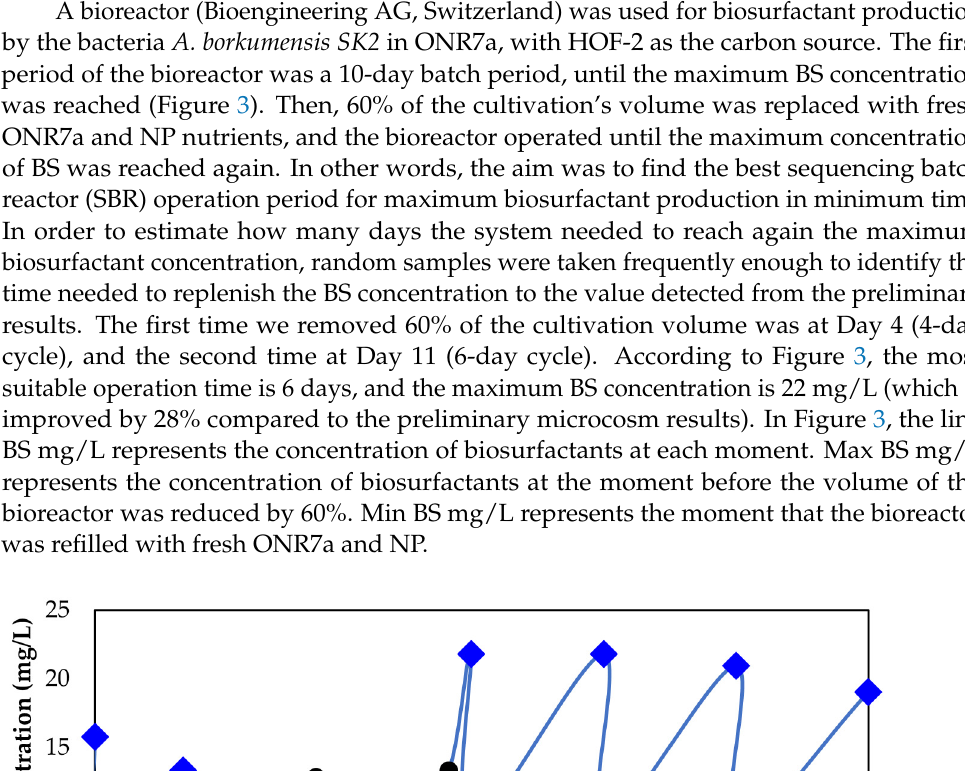
Figure 4. BFT efficiency test of BS-in-SOY agent with BS produced by Alcanivorax borkumensis SK2 . The concentration of BS diluted in soybean oil where 0%, 5%, 7.5% and 15% w/v. 3.6. Bioremediation Test In order to determine the BS efficiency in the biodegradation process, a bioremedia- tion set of experiments was done. The results revealed the BS as well as the solvent role in the bioremediation process. The saturated hydrocarbons concentration, with biosurfac- tants dissolved in both solvents, does not have a significant decrease until day 7 (Figures A2 and A3), but is reduced significantly until day 28 (Figures 5 and 6). Furthermore, Figure 7 shows that soybean oil has been a hindering agent in the biodegradation of crude oil. The average percentage of reduction of saturated hydrocarbons in 28 days is